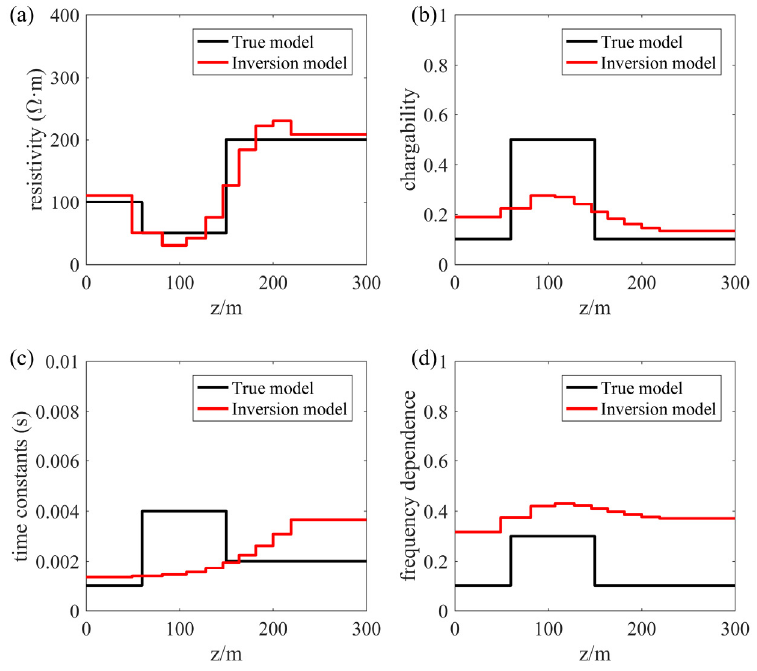
Figure 1. The inversion results of the 1D ATEM: ( a ) resistivity; ( b ) chargeability; ( c ) time constant; ( d ) frequency dependence.